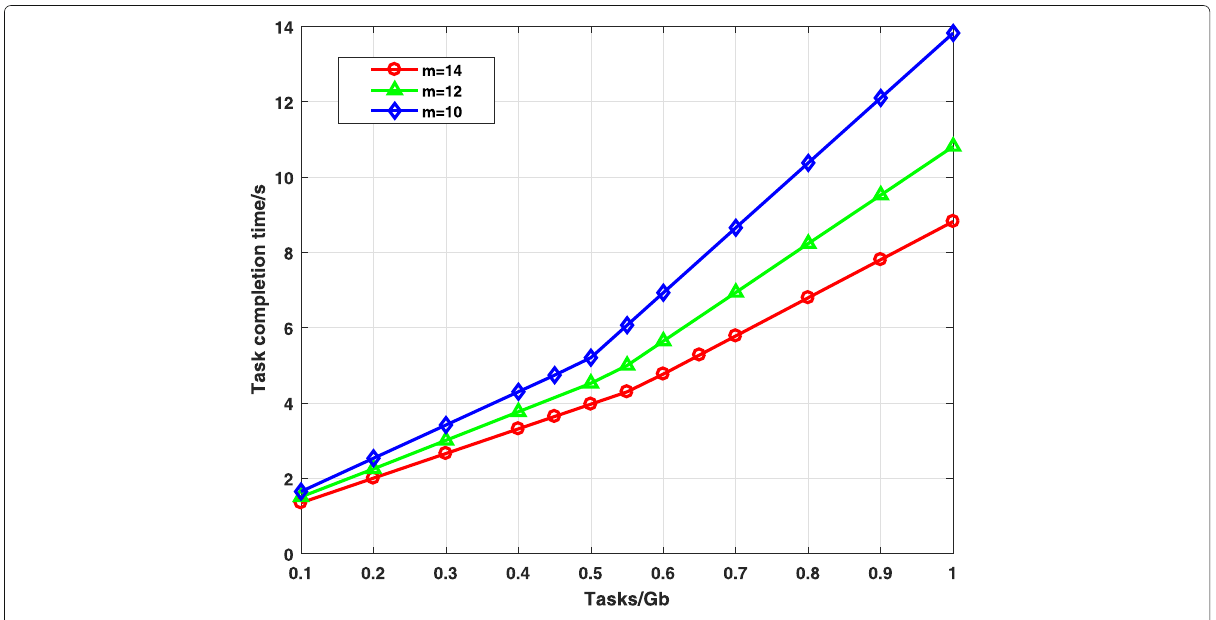
Fig. 2 The effect of the number of target nodes on the completion time